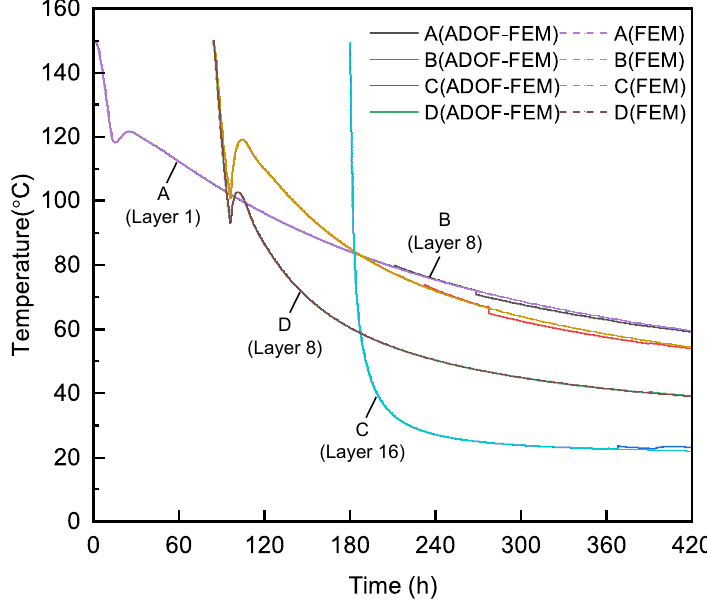
Figure 14. The temperature at typical point positions of Example